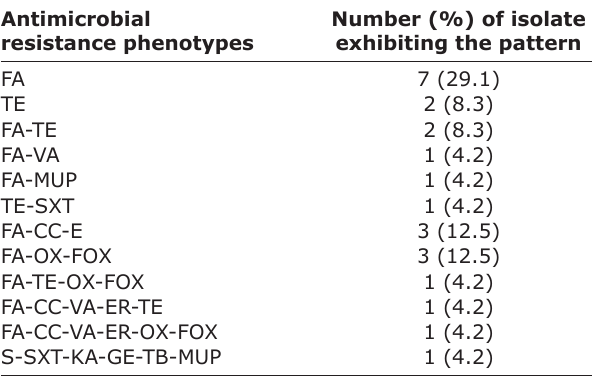
Table-5: Antimicrobial resistance patterns of Staphylococcus species (n=24) isolated from ready-to-eat meats. Antimicrobial resistance phenotypes